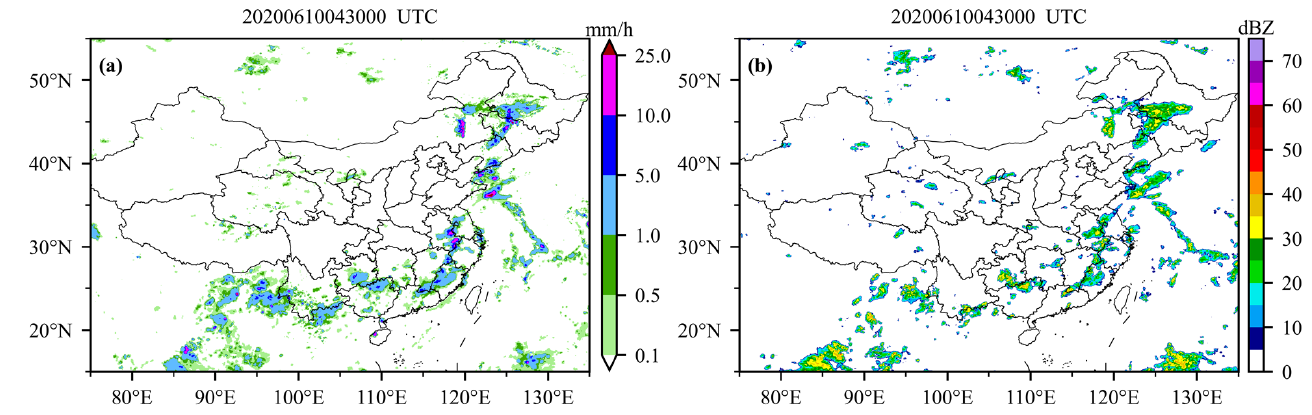
Figure 9. June 10, 2020, 04:30 UTC. ( a ) GPM precipitation distribution; ( b ) radar composite reflectivity based on the Attention U-Net VIS_IR